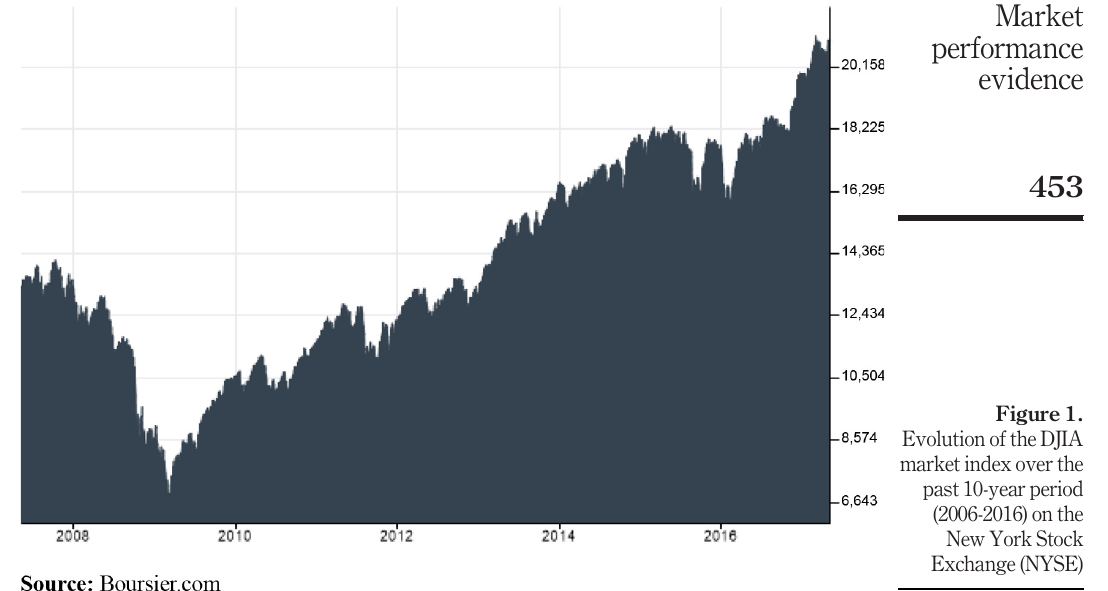
Figure 1. Evolution of the